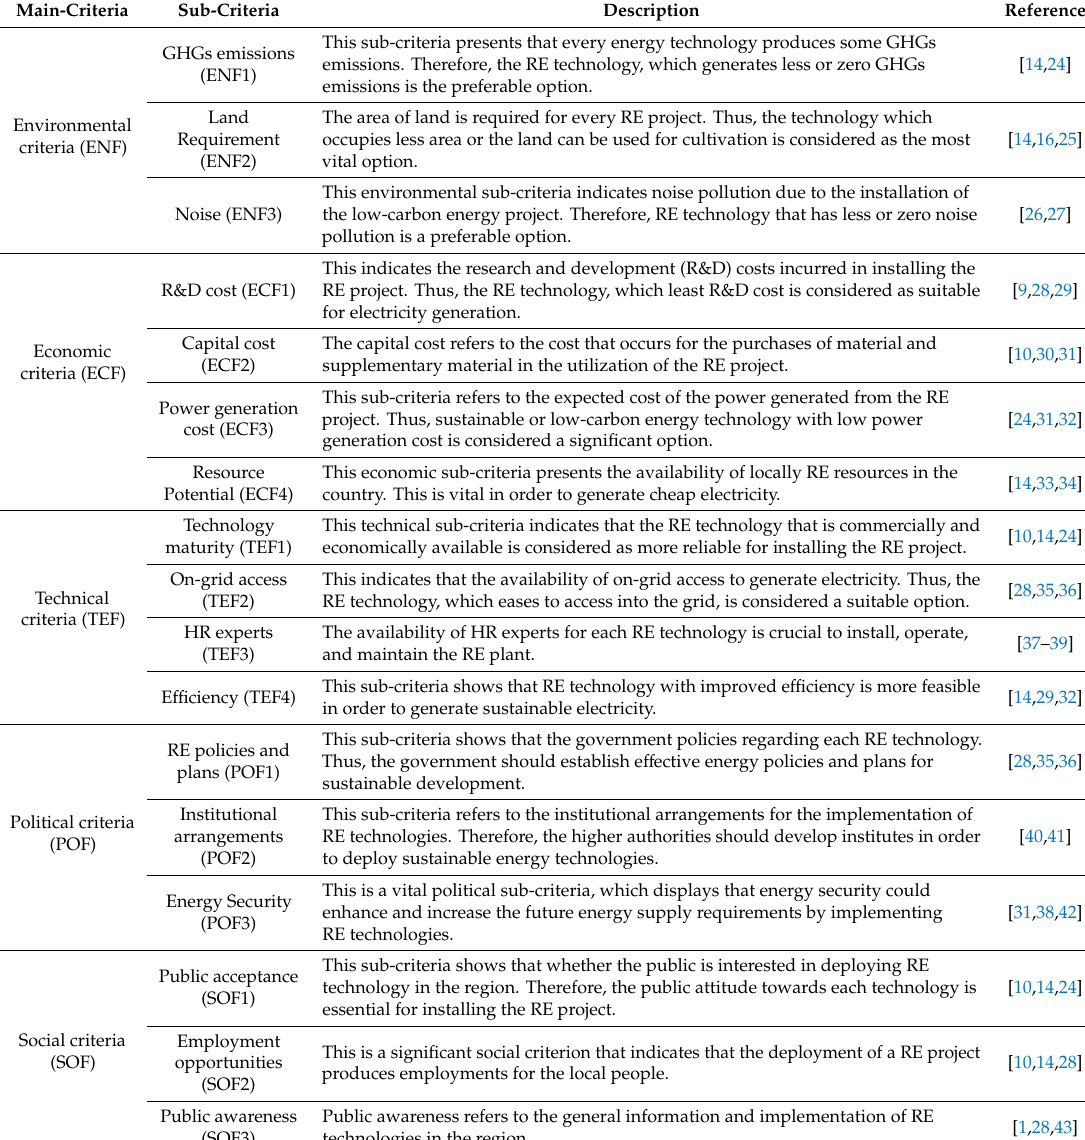
Table 2. RE main criteria and